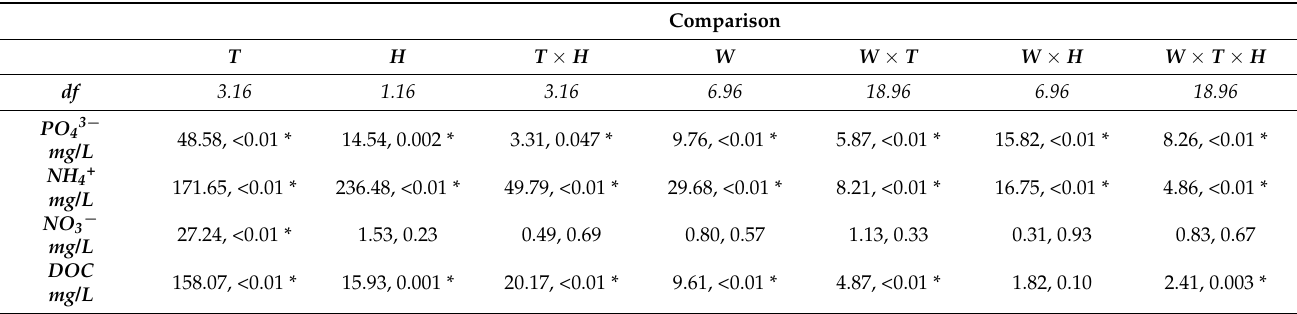
Figure 4. Major nutrient compound concentrations (Mean ± SE) in the ditch ( a , c , e , g ) and pond ( b , d , f , h ) habitats and Roundup treatments, given as differences from mean control values for each habitat. Table 2. Repeated measures ANOVA ( F , p ) results across treatment (T), habitat (H), and week (W). Significant results are indicated with an asterisk.